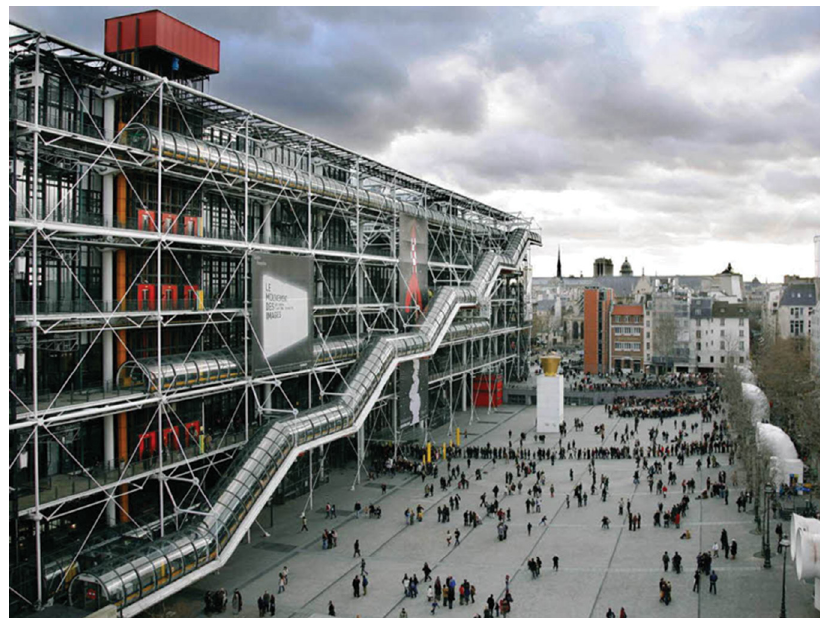
Figure 12. The architects respond to the requirement of polyvalence and plasticity by offering an interior completely empty of its internals. All the service and mechanical systems are transferred in one swooping move to the outside exoskeleton of